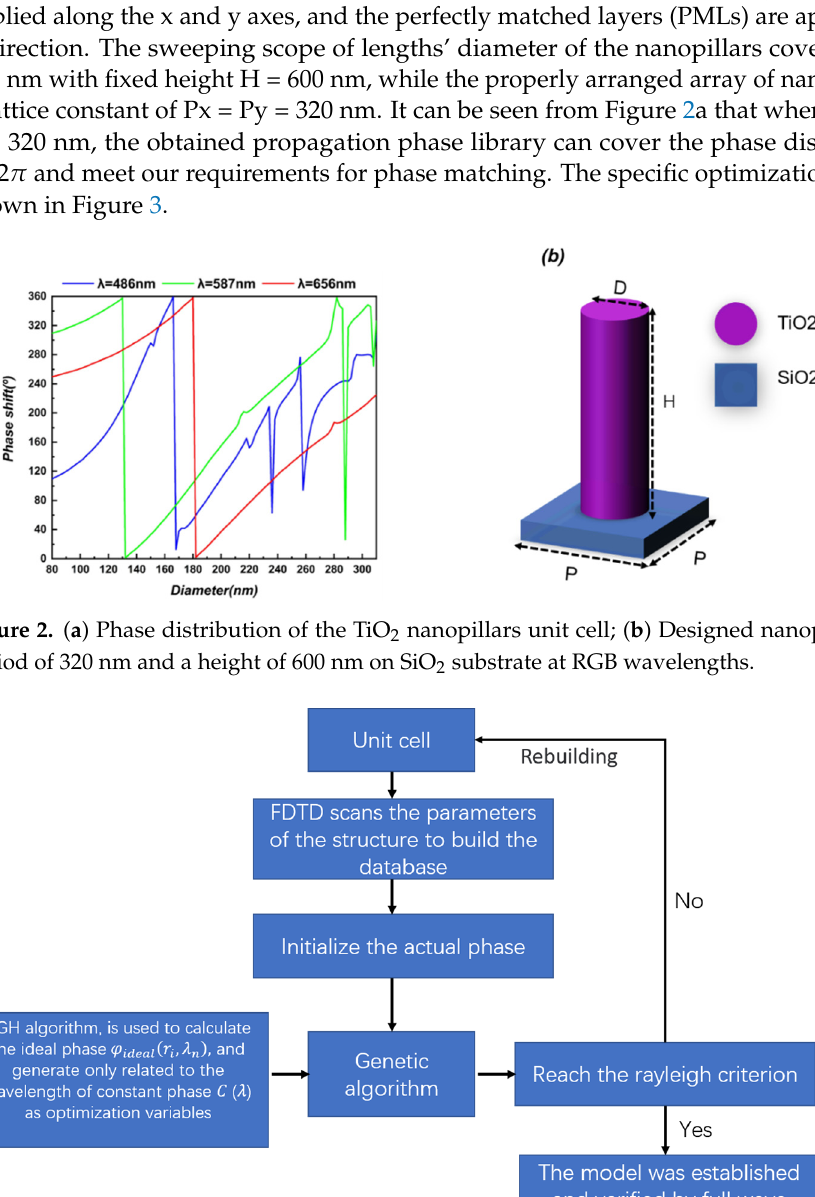
Figure 3. Application of genetic algorithm optimization flow chart in design principle.